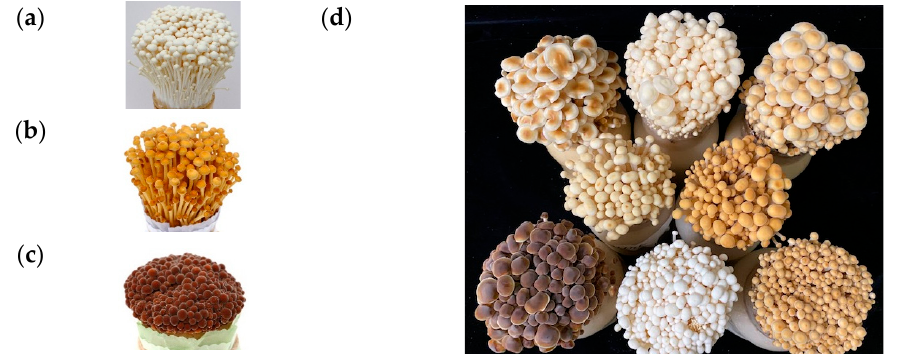
Figure 1. Color of the fruiting bodies of Flammulina velutipes strains. ( a ) F. velutipes white strain; ( b ) F. velutipes yellowish-brown strain; ( c ) F. velutipes dark-brown strain; ( d ) various colors of F. velutipes